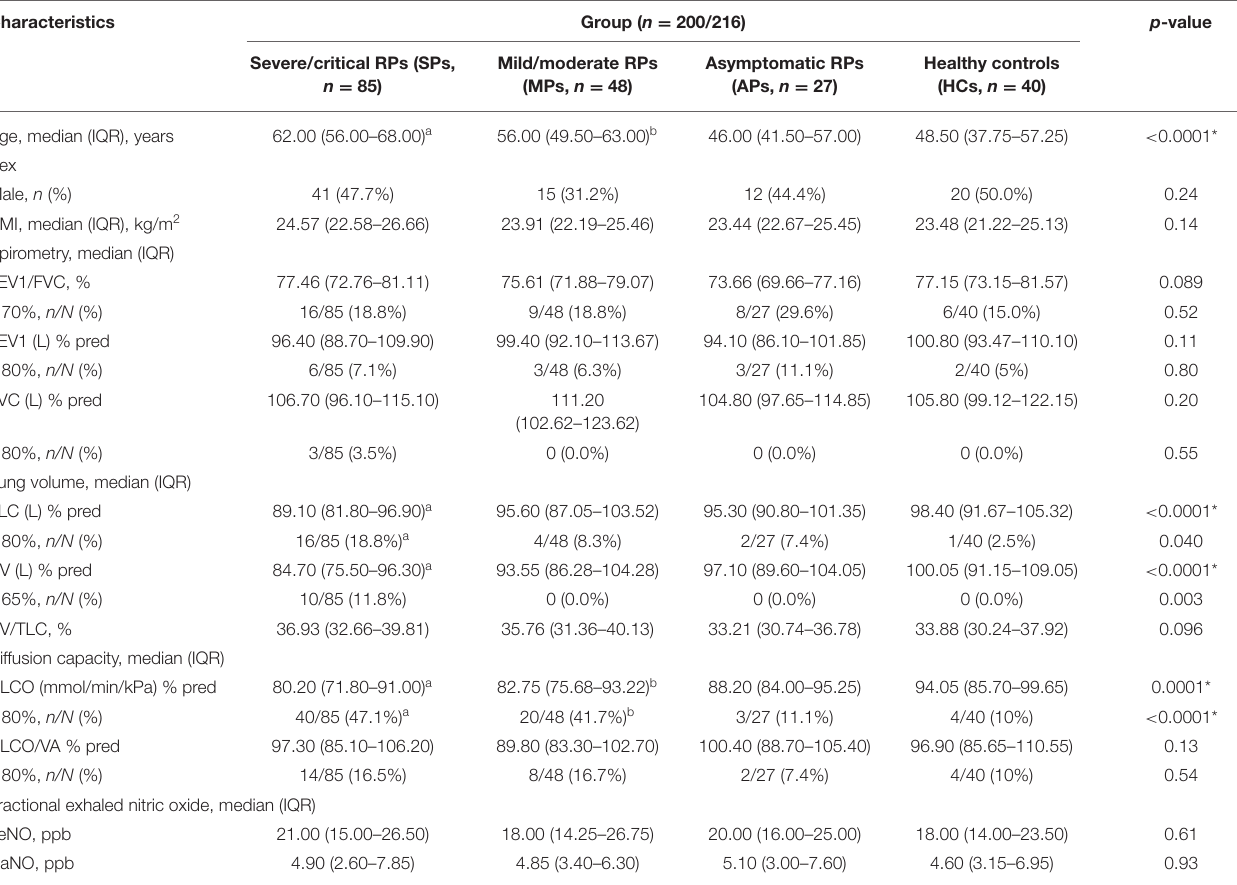
TABLE 3 | Pulmonary function test of patients recovered from COVID-19 at 3 months post-discharge.